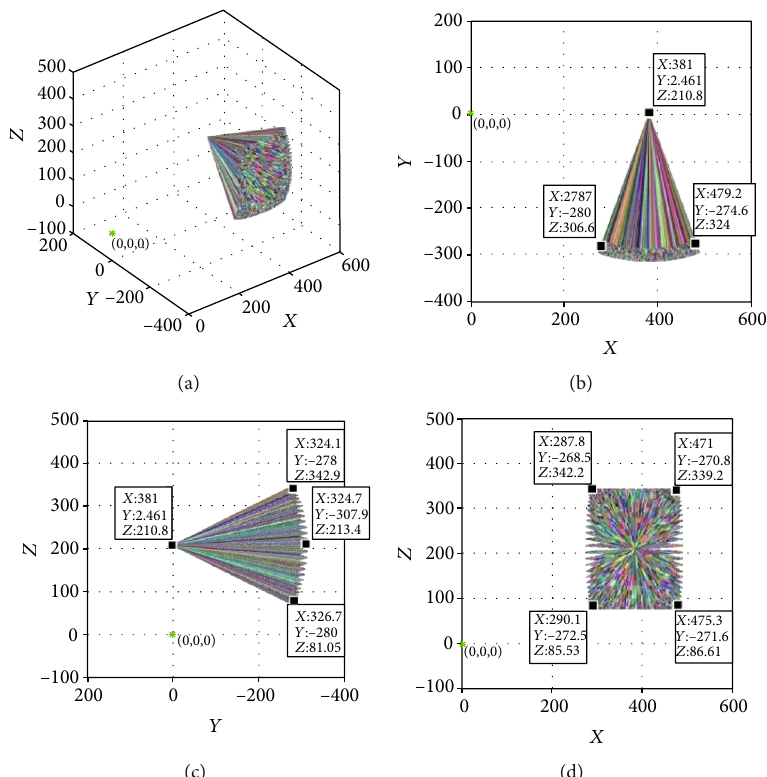
Figure 9: Posture of ultrasonic probe at 0 mm feeding: (a) three-dimensional map; (b) xoy plane projection; (c) yoz plane projection; and (d) xoz plane